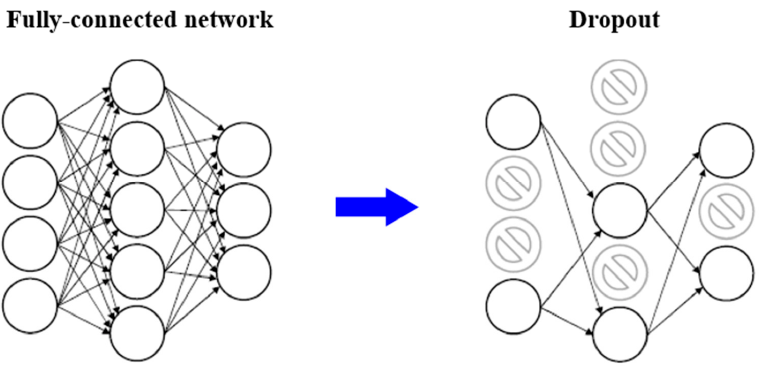
Figure 6. Schematic representation of dropout trick in a fully connected network.